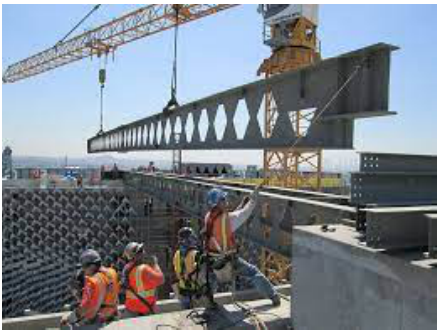
Figure 2: Castellated beams at Emerson College, Boston,